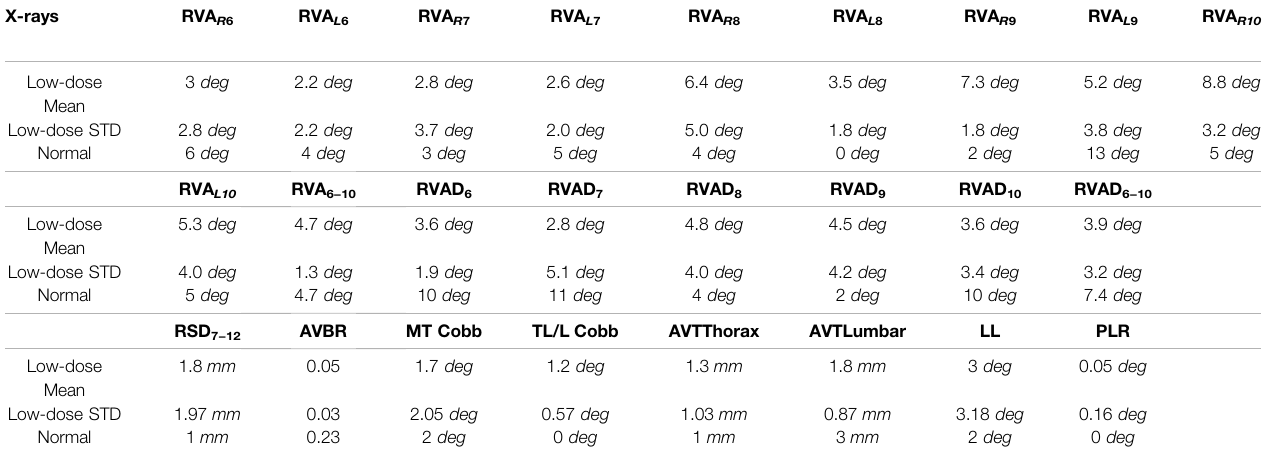
TABLE 3 | Error on the clinical evaluation metrics for the torso models resulting from our morphing.